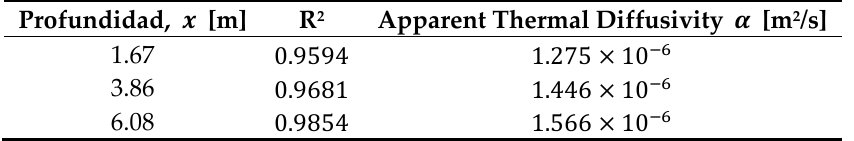
Table 1. Results for apparent thermal diffusivity obtained using the sinusoidal mathematical